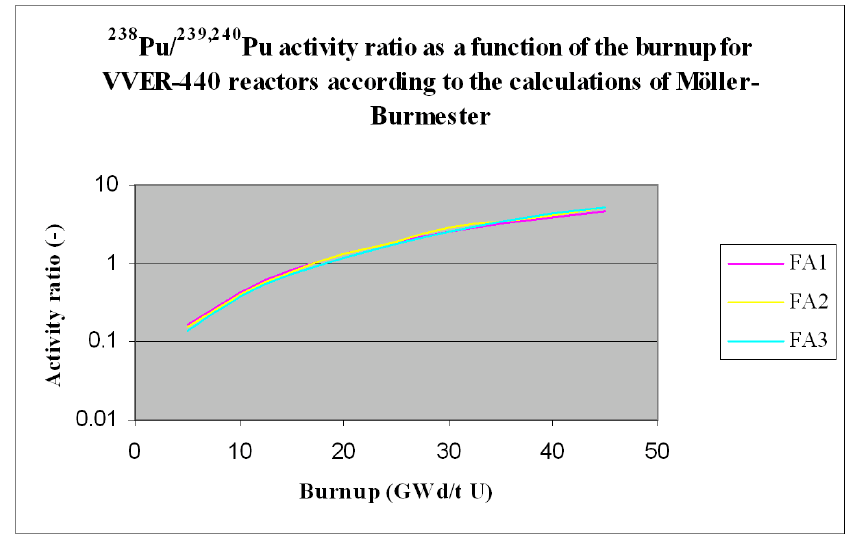
Fig. 6 238 Pu/ 239 , 240 Pu activity ratio as a function of the burnup for VVER-440 reactors accord- ing to the calculations of M¨oller-Burmeister. The FA1, FA2, FA3 represent the different initial enrichments (1.6%, 2.4%, 3.6%).